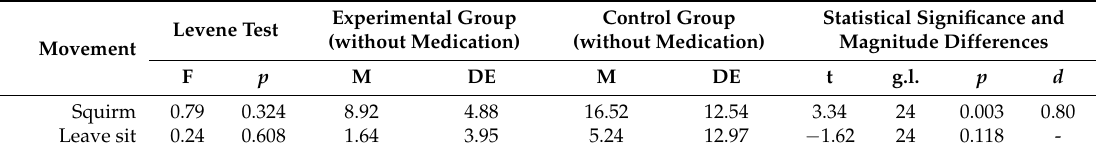
Table 5. Average differences in movement for every joint within the experimental group with and without intake of prescribed